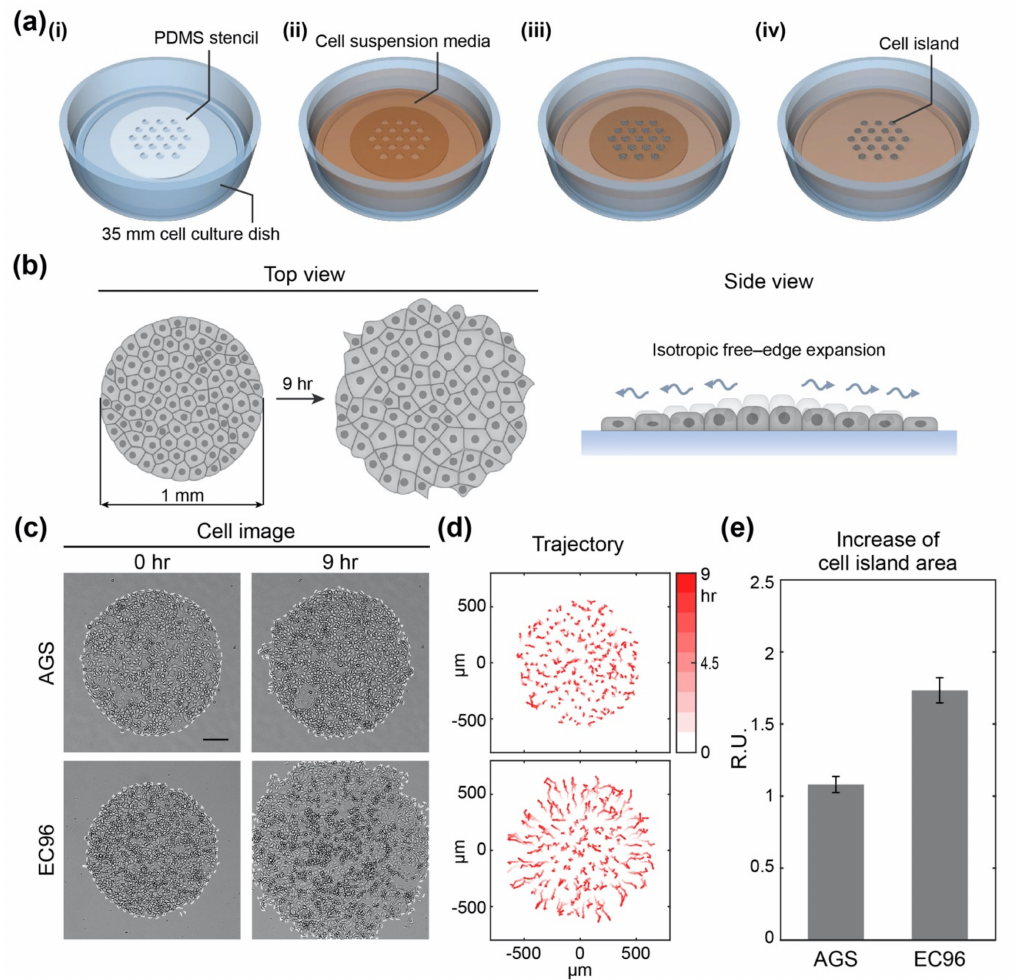
Figure 1. Experimental set-up of the isotropic free-edge expansion model and expansion of AGS and EC96 cell islands. ( a ) Schematic of circular-shaped cell island patterning for the isotropic free-edge expansion model; (i) placing a PDMS stencil in a 35 mm cell culture dish; (ii) adding cell suspension media over the stencil in the dish; (iii) incubating the dish for the cells to settle down within the holes of the stencil; (iv) removing the stencil to release the cell island to begin the expansion assay. ( b ) Schematic of the experimental model for isotropic free-edge expansion. ( c ) Bright-field images of AGS and EC96 cell islands at 0 h and 9 h after release (scale bar = 200 µ m). ( d ) The trajectory of the cells within the AGS and EC96 cell islands. The stronger red color of the arrows indicates more time passed. ( e ) Relative increase rate of the AGS and EC96 cell islands. The error bars represent the standard errors calculated from separate assays on each group ( n =